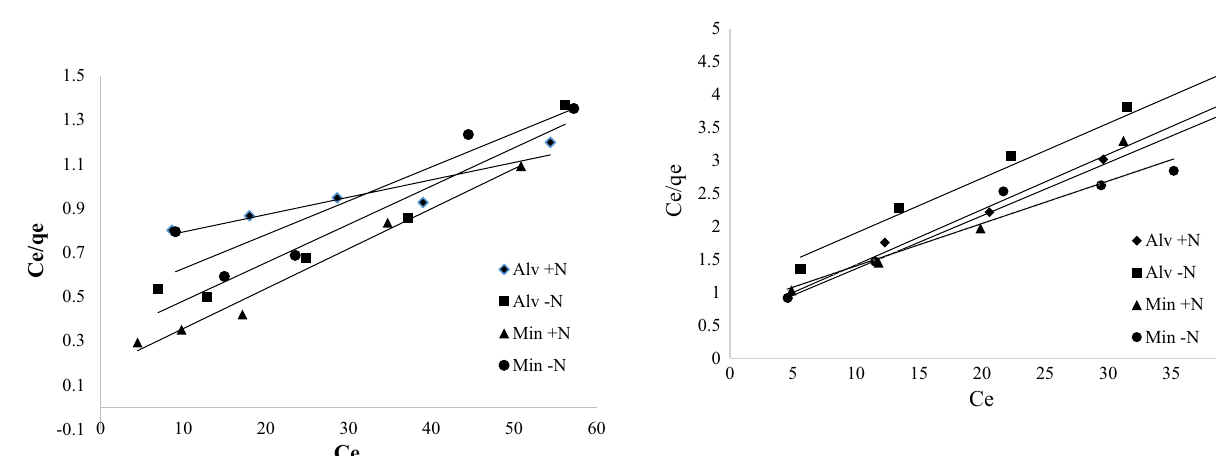
Fig. 6 Langmuir isotherm for lead ions onto N. alveolaris + N, N. alveolaris